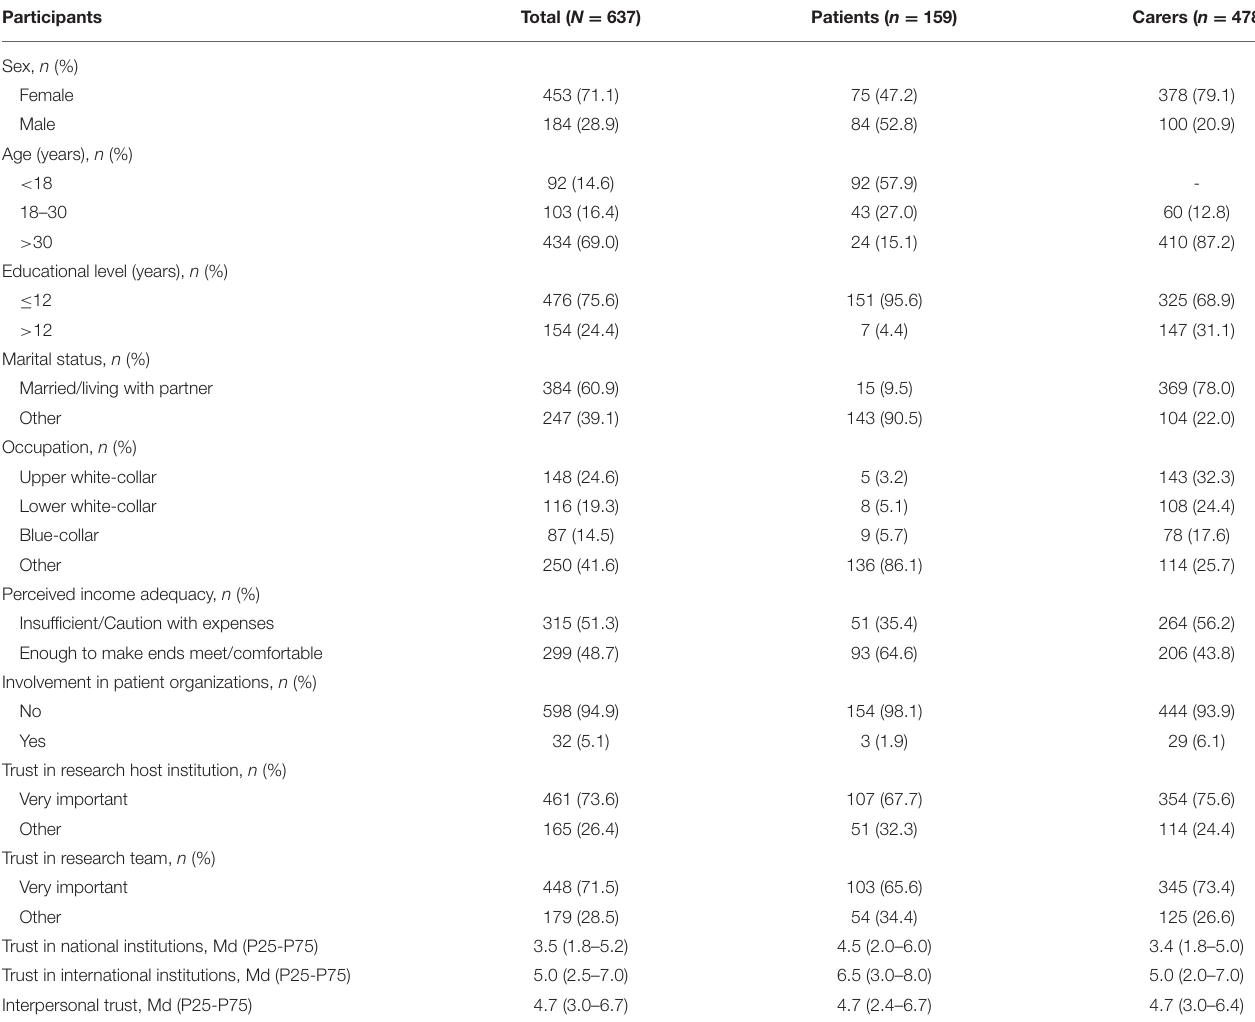
TABLE 1 | Characterization of the participants, stratified by people with rare diseases and their informal